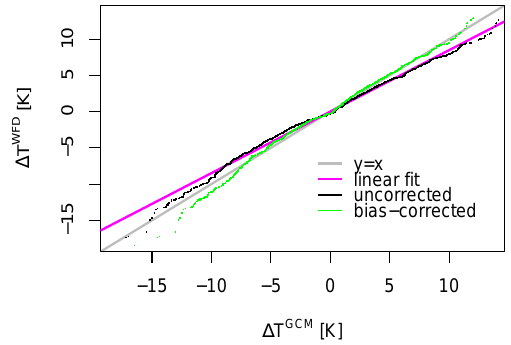
Fig. 4. Rank ordered residual observational versus simulated tem- perature values for all April days during the reference period for the example grid cell. The uncorrected GCM data are shown in black with the fitted regression curve overlaid (red). Statistically identical data would lie on the y = x curve (grey). The bias-corrected GCM data are plotted in